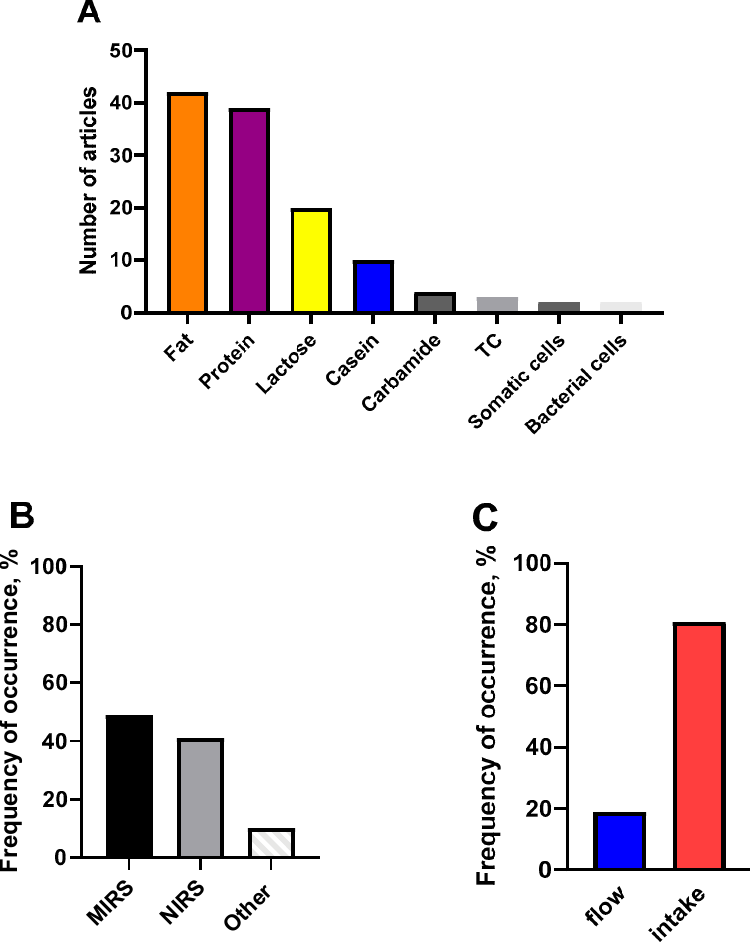
Figure 2. Comparison of the main characteristics of milk analyzers: ( A ) Distribution of devices according to the analyzed characteristics of milk; TC—Technical characteristic; ( B ) Distribution of devices according to the used frequency range; ( C ) Allocation of analyzers by parameter flow/sampling.